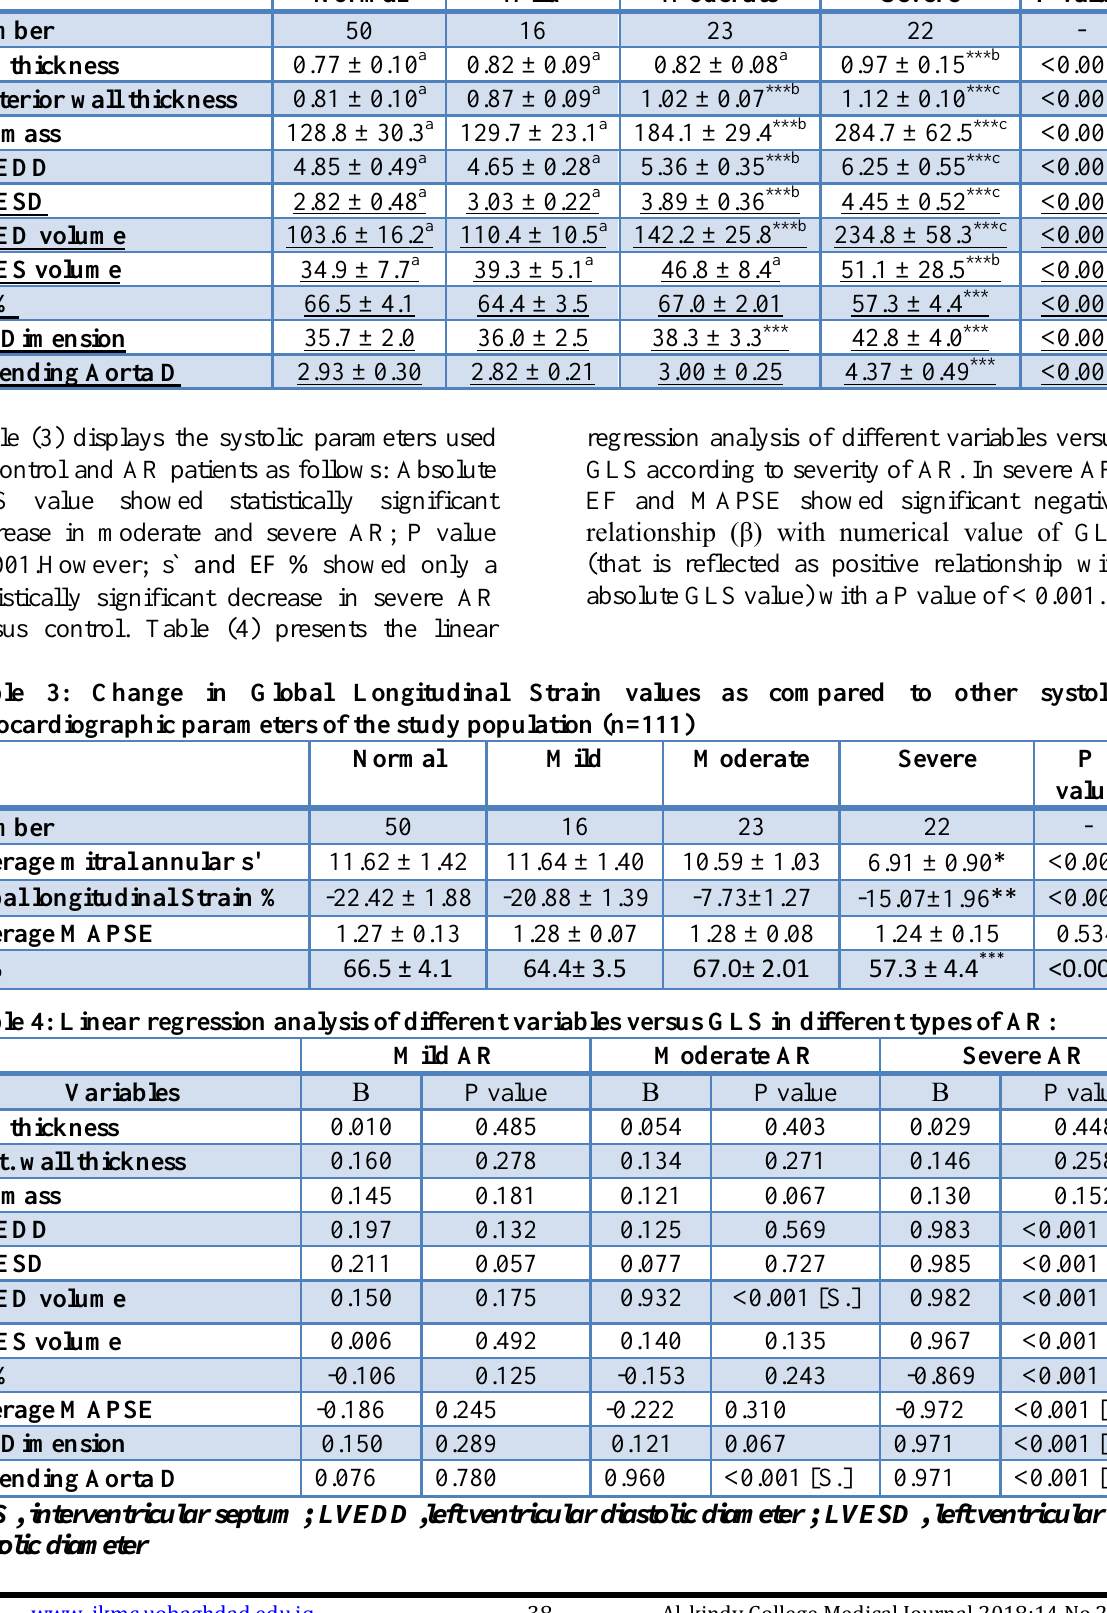
Table 2: echocardiographic data of the study population (n=111) Normal